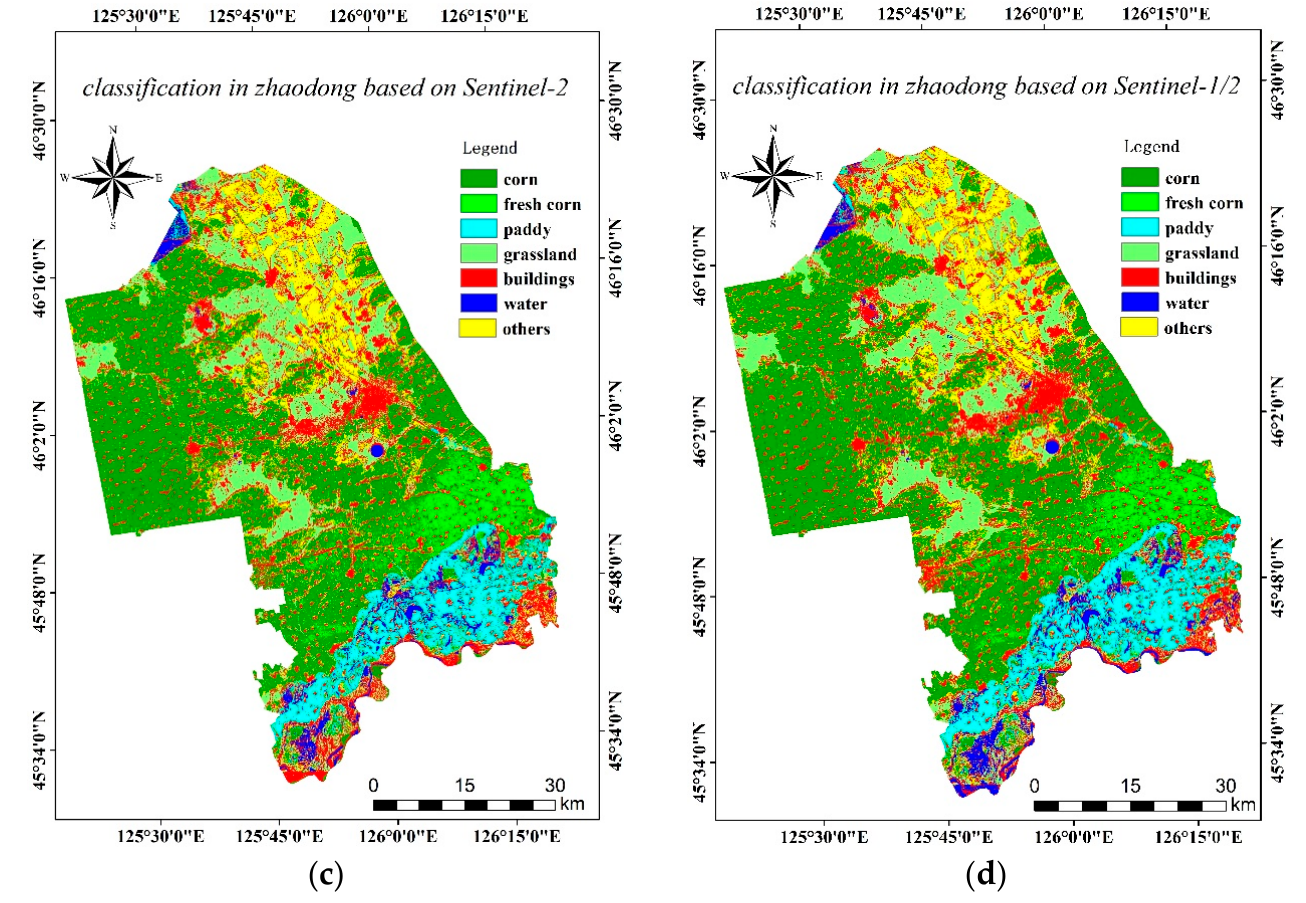
Figure 4. Classification results based on optical and SAR remote sensing images (reference frame: WGS84/UTM51N). Note: Figure ( a ) shows the classification results of S7 with GF6 optical data, Figure ( b ) shows the classification results of S8 with GF6 optical data and GF-3 SAR, and Figure ( c ) shows the classification results of S11 with Sentinel-2 optical data. Figure ( d ) shows the classification results of S12 with Sentinel-2 optical data and Sentinel-1 SAR data.